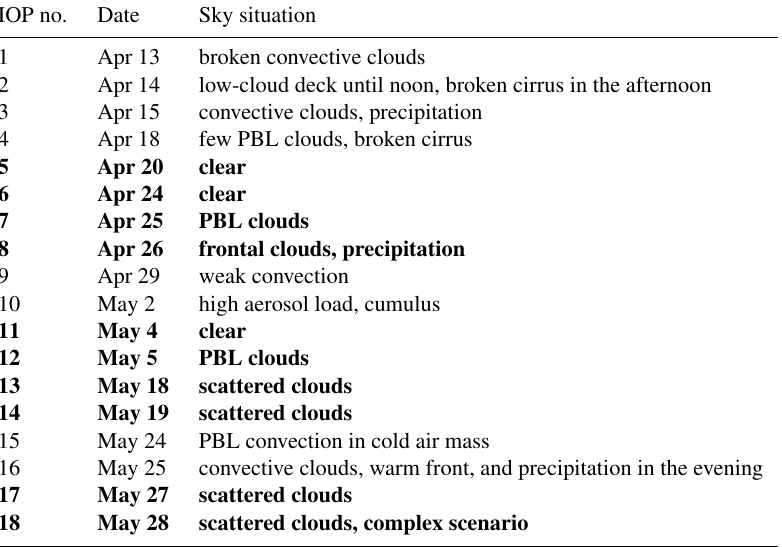
Table 3. Summary of intensive observation periods during HOPE-Jülich. Bold typeface denotes “golden days”. IOP no.